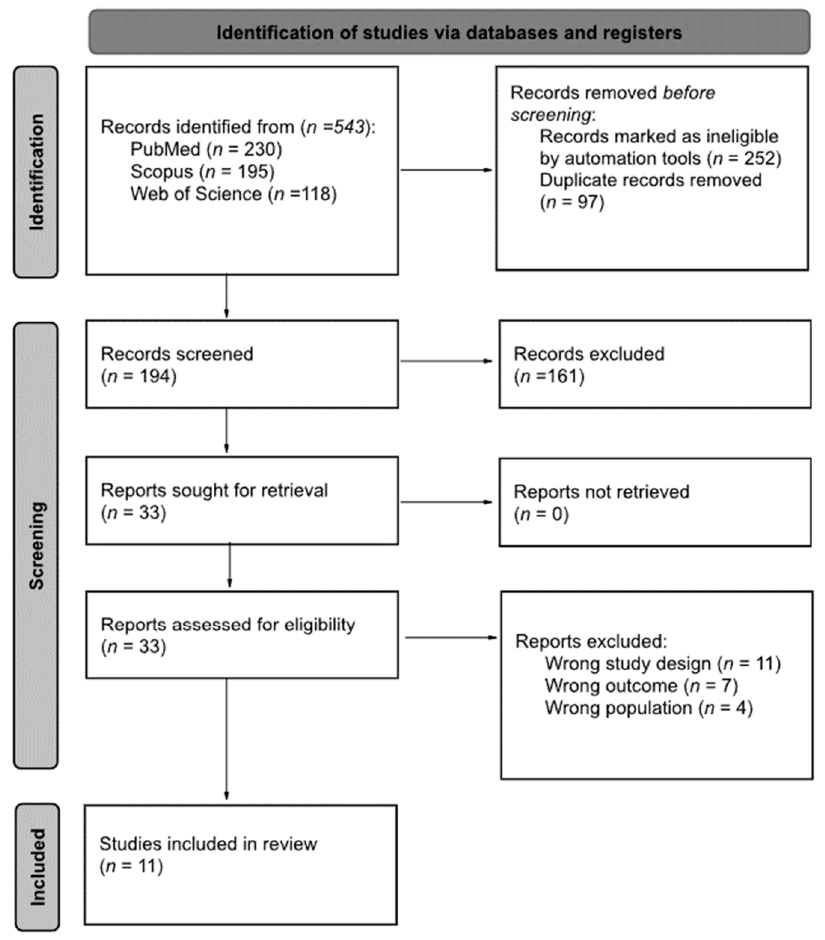
Figure 1. Flow diagram of the study selection process. Table 1. Methodological quality of the articles